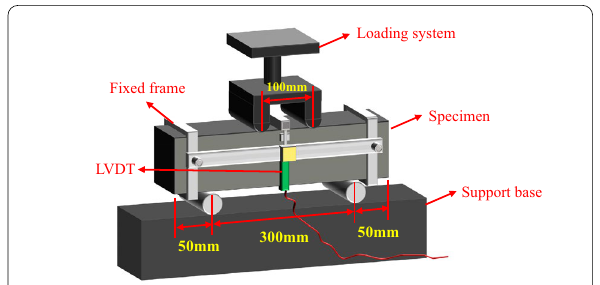
Fig. 3 Loading diagram of four-point bending test.